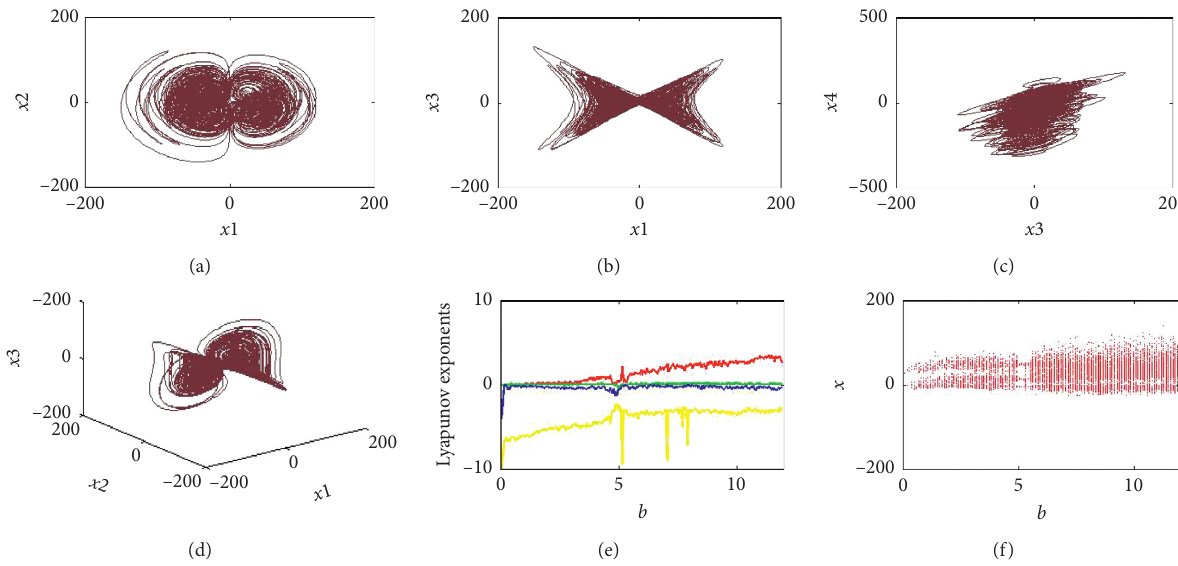
Figure 2: (a) y attractors; (d) y diagram for control parameter b